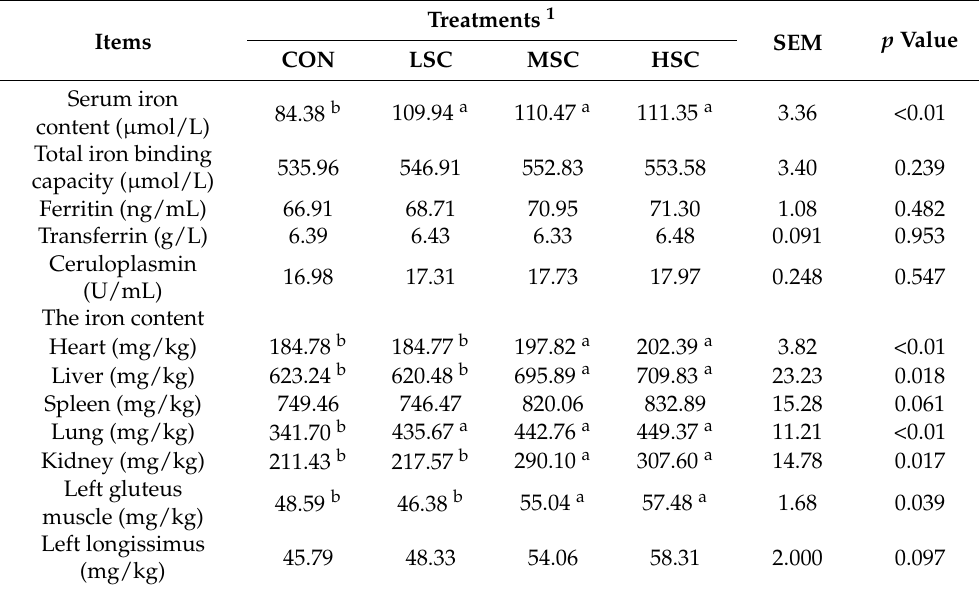
Table 3. Effect of yeast iron on serum iron indexes and the iron content in tissues and organs of weaned piglets.